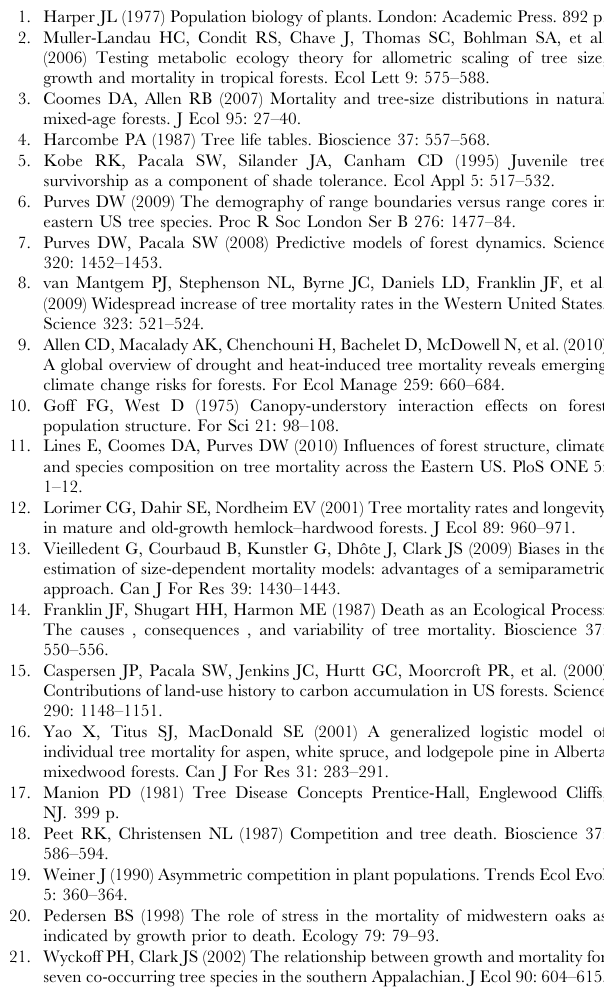
of sampled parameter estimates for individual-based mortality models for small (D , 20 cm) and large (D $ 20 cm) trees. Note that input variables were centred and standardised before inclusion in individual-based models (see Table S2b for mean values for each variable). Table S2 Mean ( 6 SD) of each variable in the raw data, across three census periods, for small (D , 20 cm) and large (D $ 20 cm)